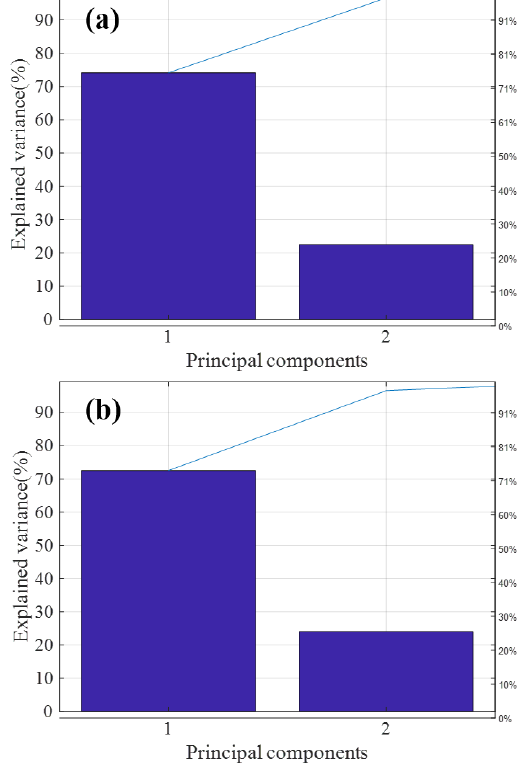
Figure 5. Principal component analysis (PCA) feature extraction of T9 and ATP2000 samples. ( a ) PCA feature extraction of the master spectrometer T9; ( b ) PCA feature extraction of the slave spectrome- ter ATP2000.